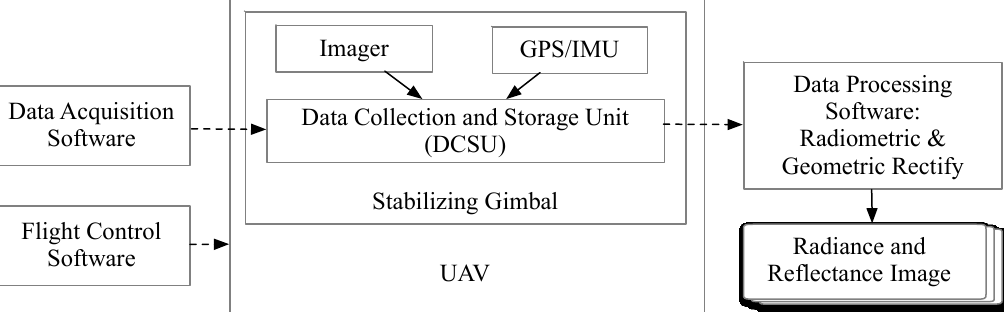
Figure 1. Scheme of unmanned aerial vehicle (UAV) hyperspectral imaging system integration.